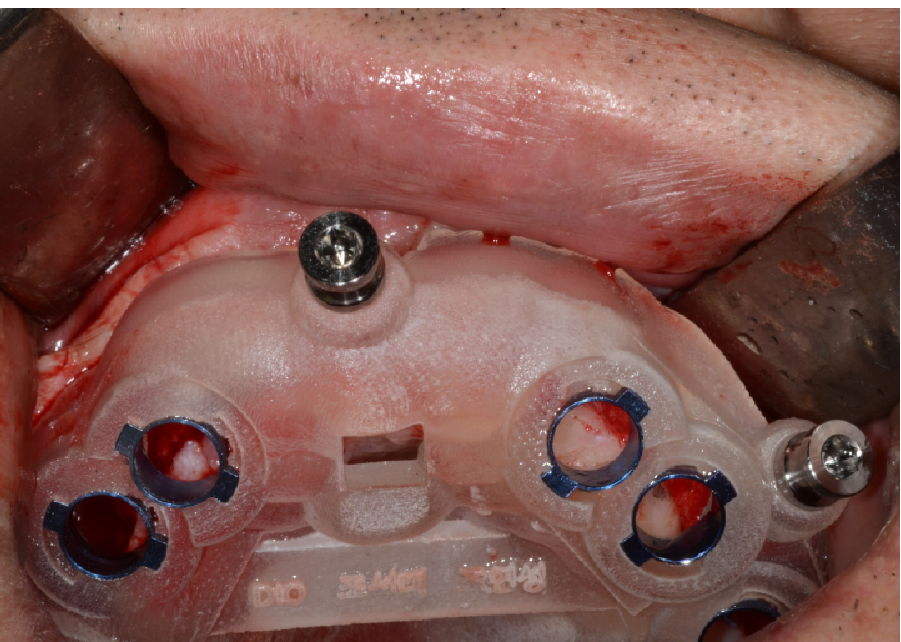
Figure 5. Surgical guide for full-guide implant surgery; bone-supported.